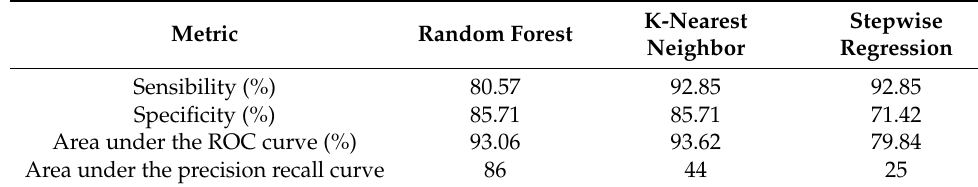
Table 1. Benchmark of model performance among ML methods for classifier construction. Algorithms employed were random forest, K-nearest neighbor, and stepwise regression. Metrics evaluated consisted of the area under the ROC curve, sensibility, and specificity. The best performing method was random forest, clearly over-performing the remaining algorithms.